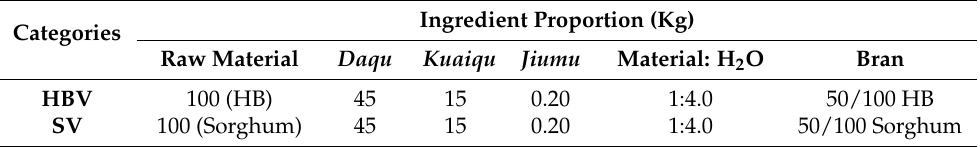
Table 1. Ingredient proportion for vinegar